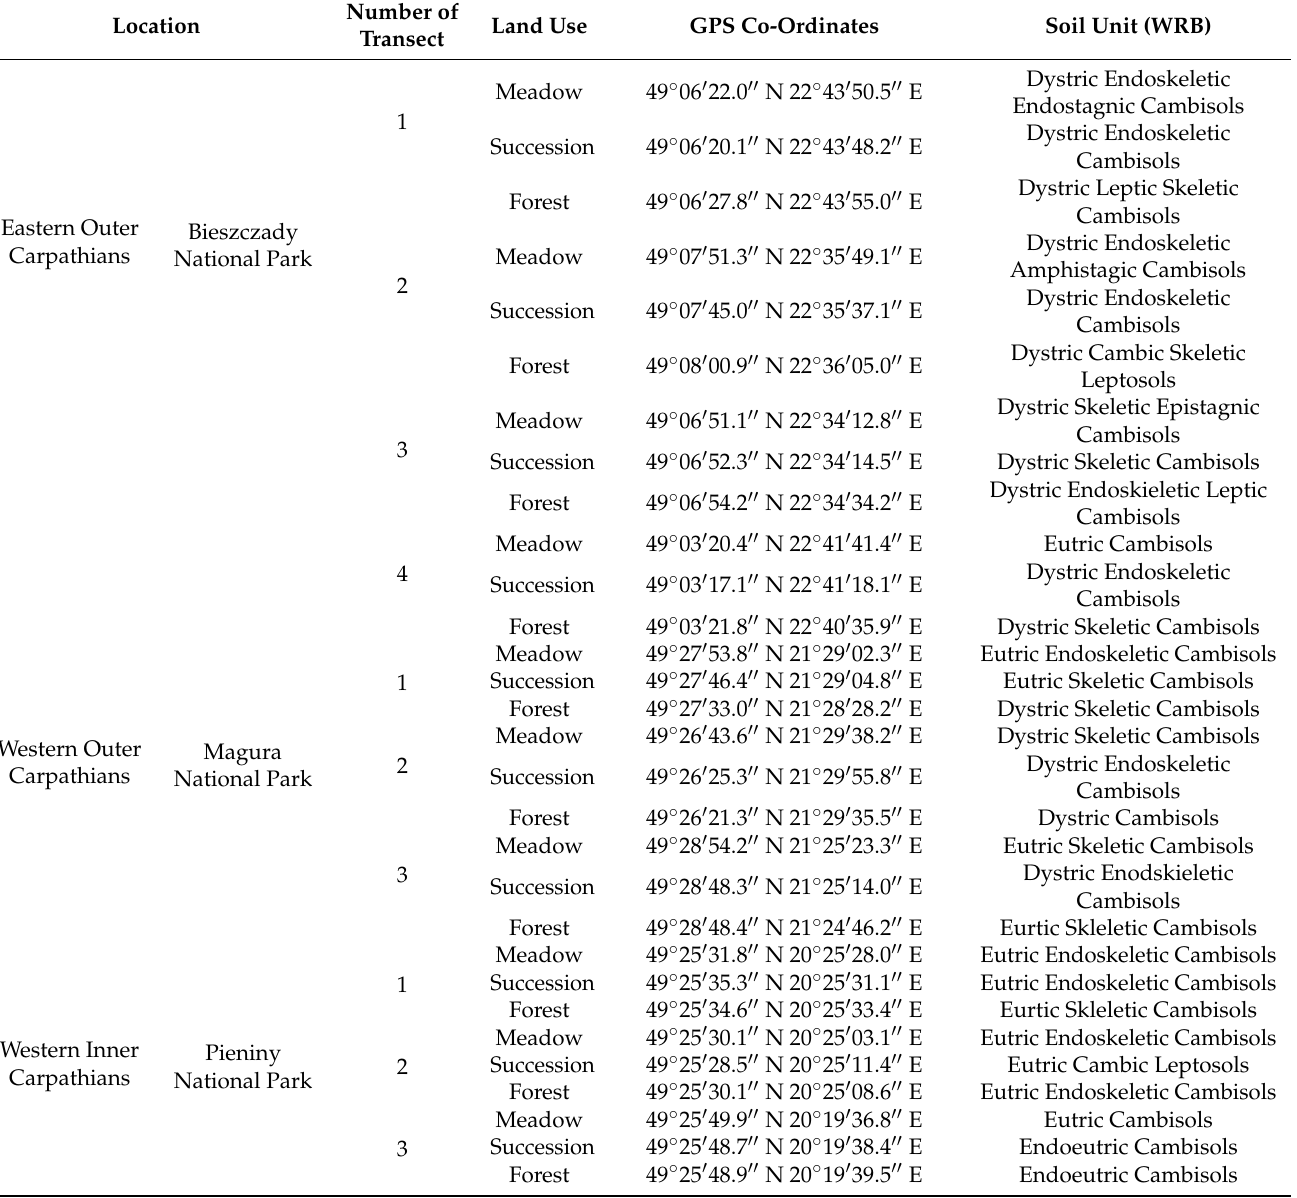
Table 1. Location of the study areas and soil units at the area of the transects according to World Reference Base for Soil Resources (WRB) classification (IUSS Working Group WRB,